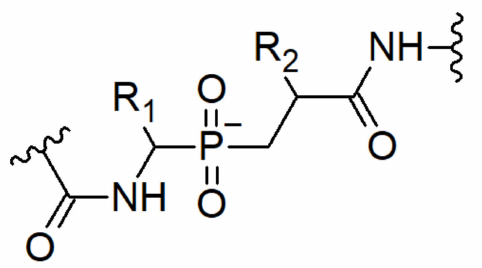
Figure 5. Common structural motif in phosphinopeptides